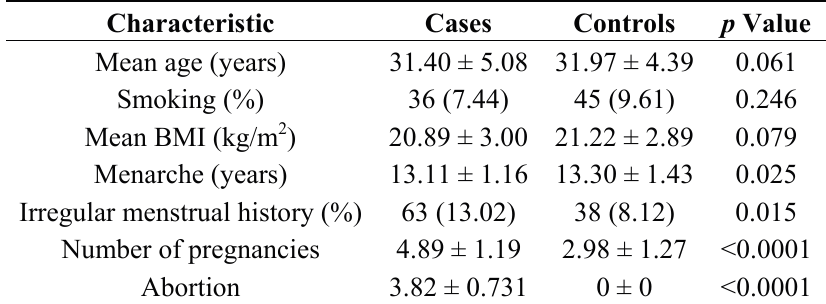
Table 1. Clinical characteristics of the study